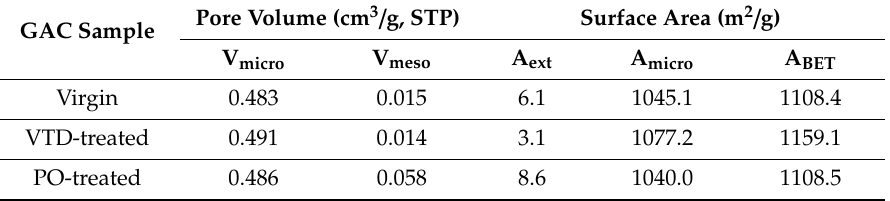
Table 1. Porous texture of virgin, VTD-treated and PO-treated GAC samples as determined by high-resolution α s -plots (V micro , V meso , A ext and A micro ) and BET (Brunauer-Emmett-Teller) plot (A BET from Figure S2).